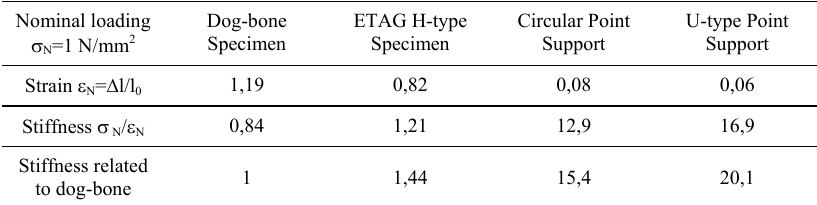
Table 3: Compliance properties (numerical